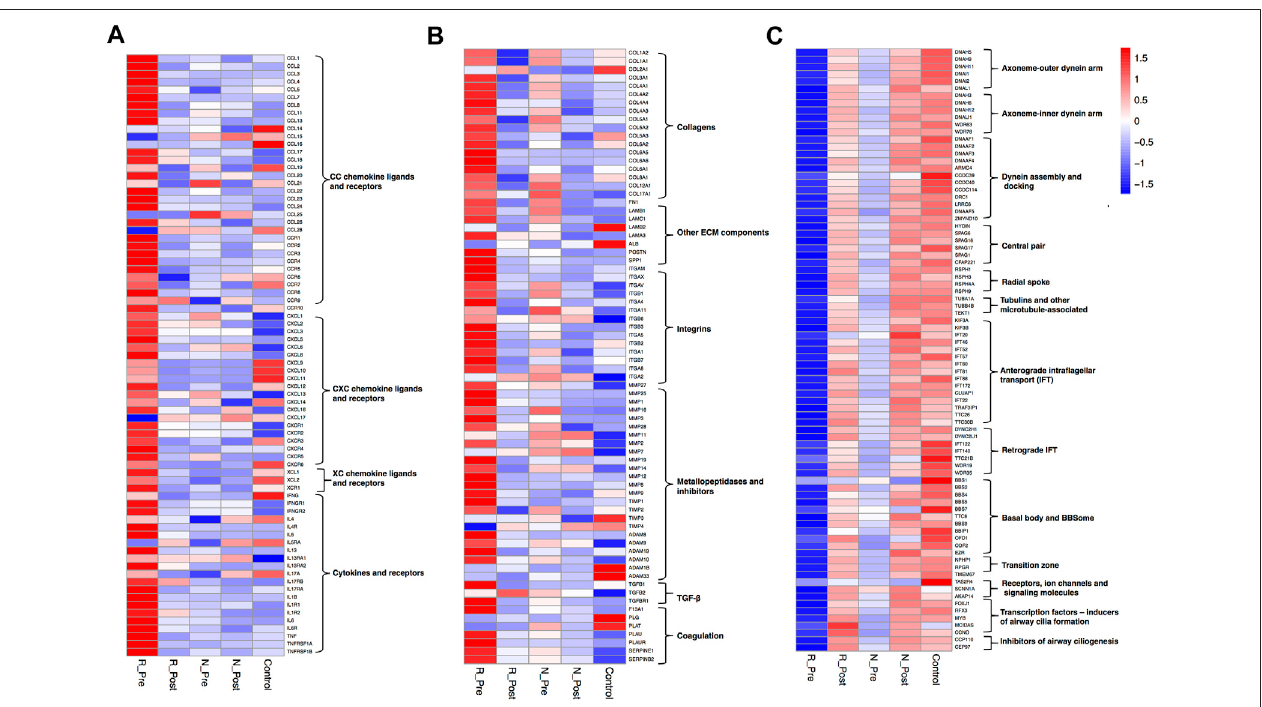
FIGURE 2 | Heatmaps depicting the mean mRNA expression values of multiple chemokines, cytokines and corresponding receptors (A) , genes involved in extracellular matrixmetabolism (B) , and genesrelated to cilia (C) inR_Pre ( n (cid:1) 9), R_Post ( n (cid:1) 9), N_Pre ( n (cid:1) 5), N_Post ( n (cid:1) 5), and Control ( n (cid:1) 5). See Supplementary Figure S6 and Supplementary Tables S5 – S7 for more